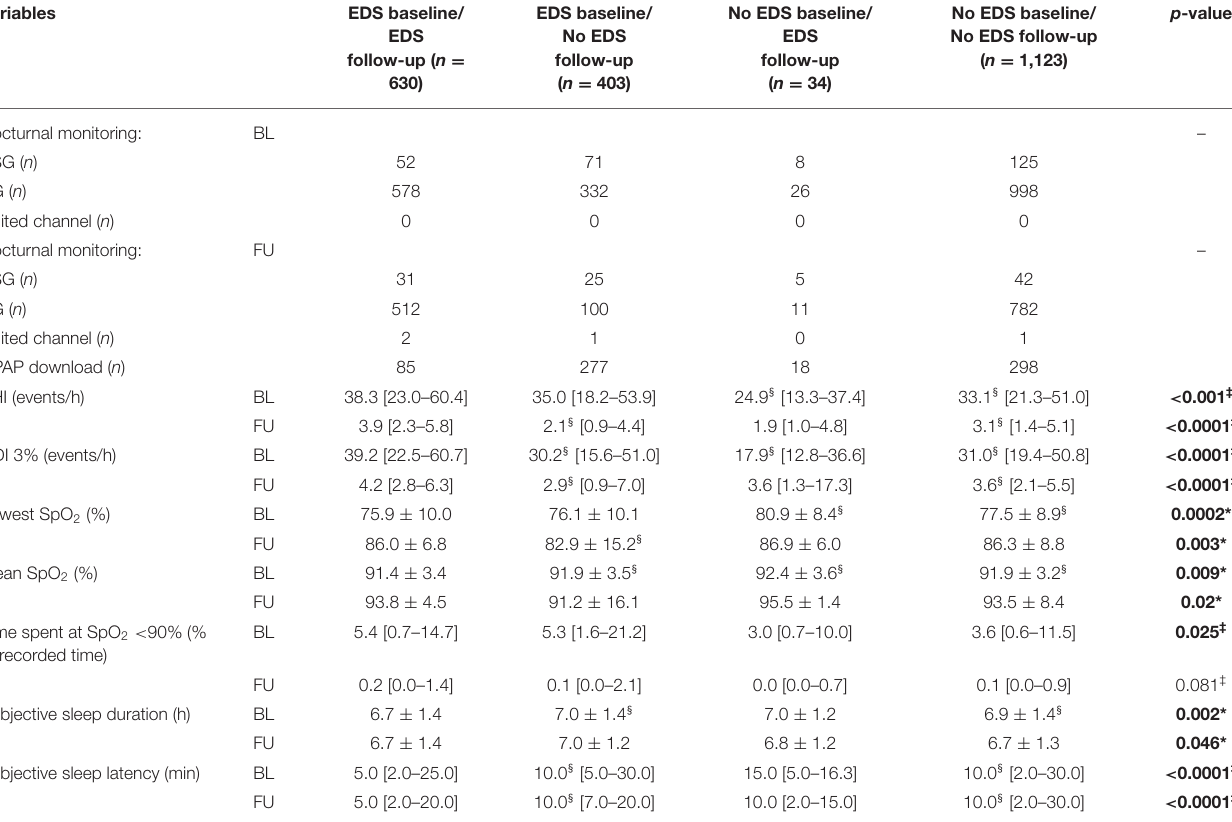
TABLE 4 | Sleep monitoring data at baseline and at the first follow-up visit according to occurrence of excessive daytime sleepiness (EDS) at baseline and follow-up. Variables